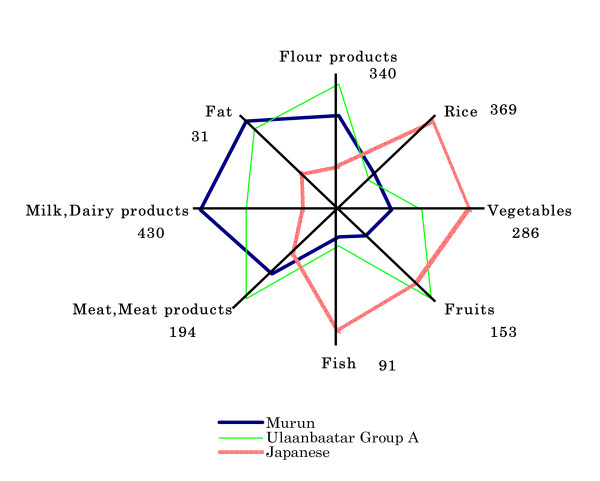
Comparison of daily food intake (g/day) among Murun, Ulaanbaatar Group A and Japanese subjects. Murun subjects seldom eat vegetables or fruit. Ulaanbaatar Group A subjects lived by urbane-styles and ate high amounts of fruits.